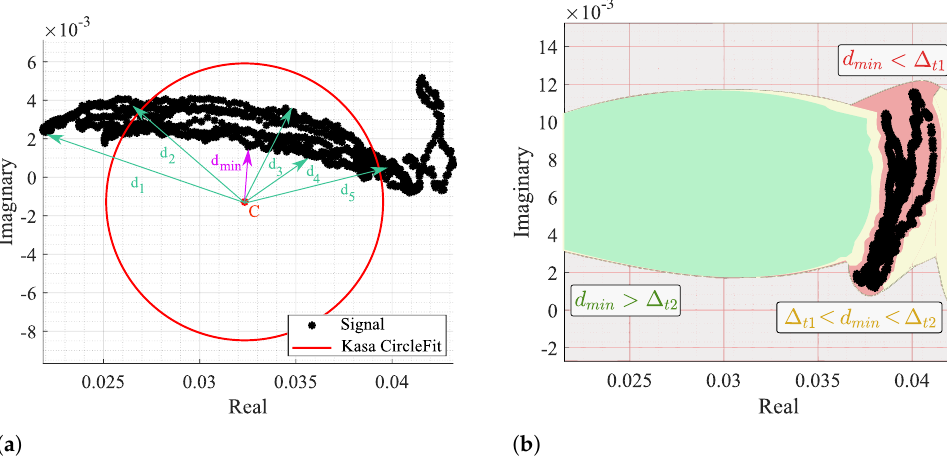
Figure 13. Identification of a failure case: ( a ) Illustration of the distance computation and d min identification, ( b ) Color map of the defined thresholds—red zone is defined when d min ≤ ∆ t 1 ,